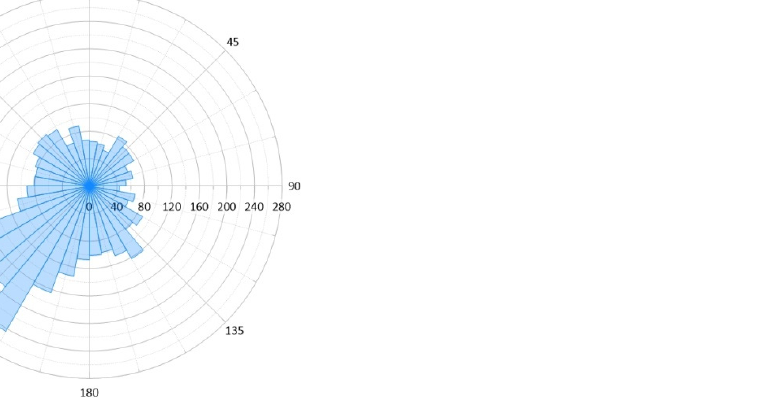
Figure 3. The wind speed and direction distribution (wind rose) at the Staroselsky Moch peatland in the summer of 2016.